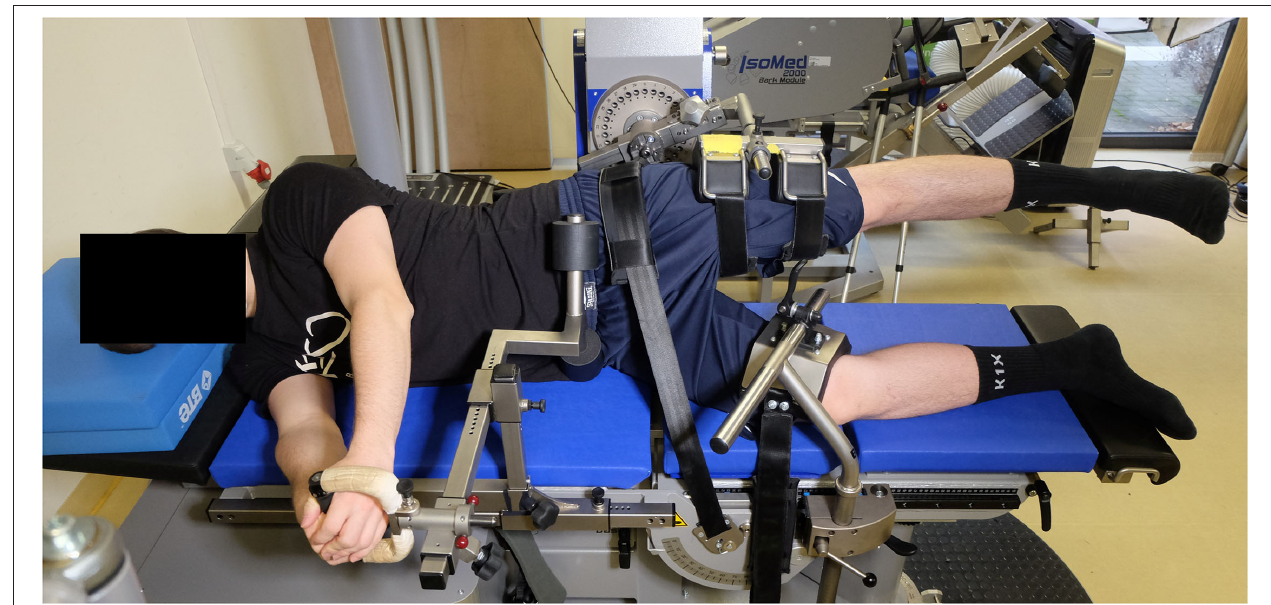
FIGURE 3 | Set-up of the IsoMed 2000 dynamometer and participant positioning for the hip strength testing.